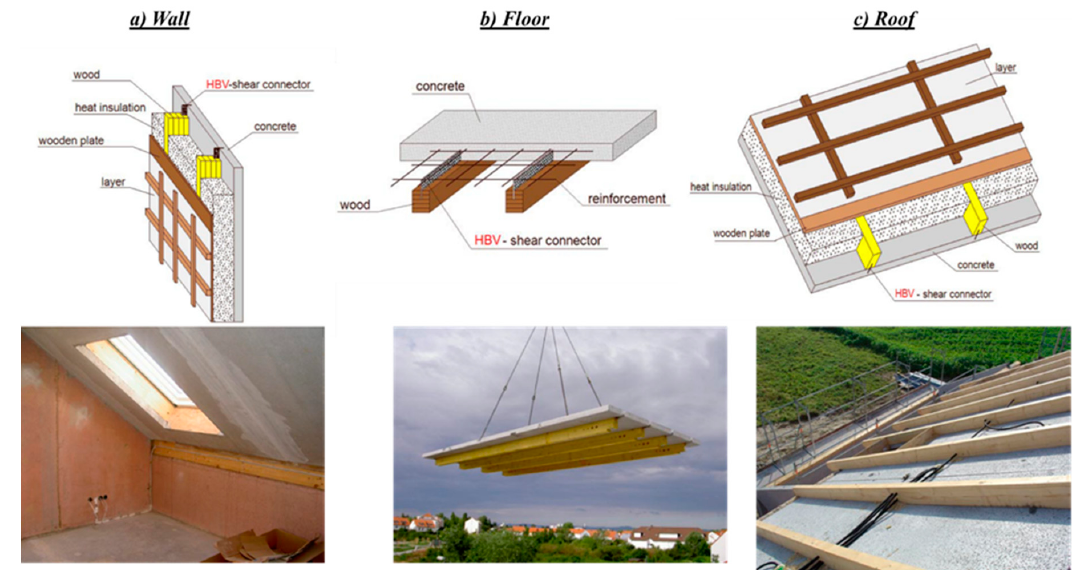
Figure 8. Wind loads based on hurricane conditions [63]. A full-scale simulated wind load test was conducted on a prefabricated panelised steel framed single storey building at the Cyclone Testing Station, Australia [64]. The testing evaluated the transmission of load sharing (i.e. uplift and lateral loads) across the various panelised elements such as the wall, ceiling, roof, connections, etc. The results show that the prefabricated panelised steel framed building performed well when subjected to static loads simulating the lateral and uplift for 50 ms -1 . However, during load cycling to simulate cyclonic wind load fluctuations, failure occurred